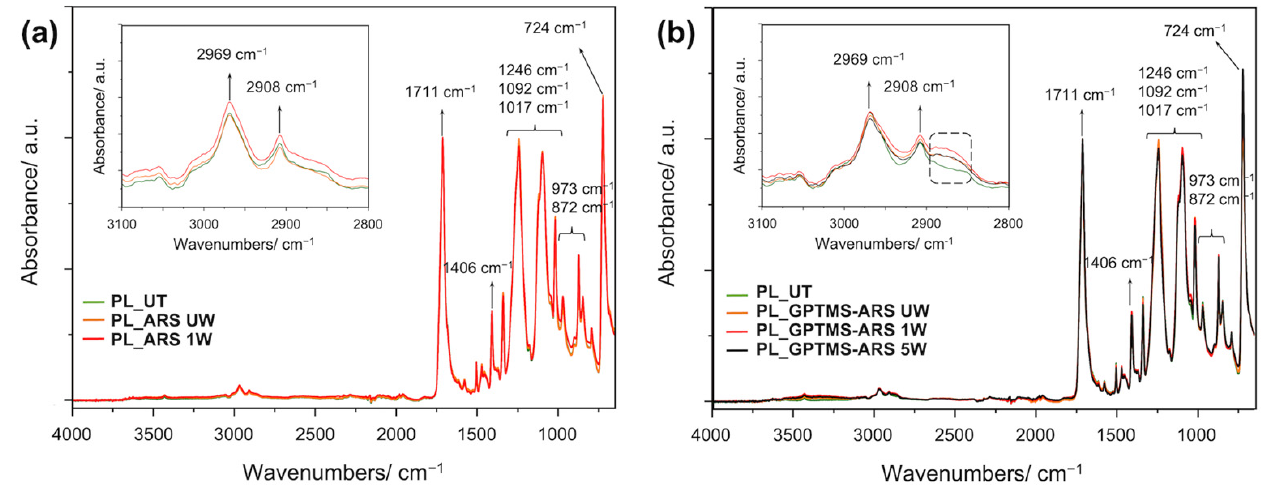
Figure 1. ATR-FTIR spectra of pristine polyester fabrics (PL_UT), dyed with plain ARS ( a ) and treated with silane-functionalized ARS ( b ) before (_UW) and after 1 and 5 washing cycles (_1W and _5W, respectively).